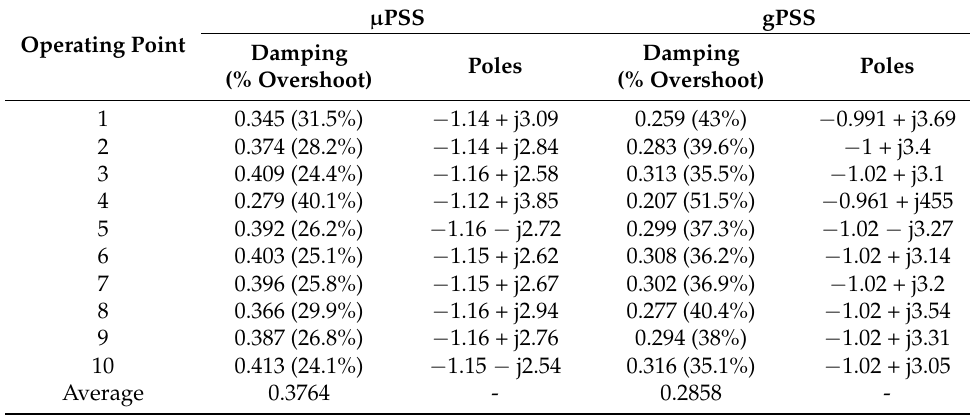
Table 6. Location of the pole in electro-mechanical mode.